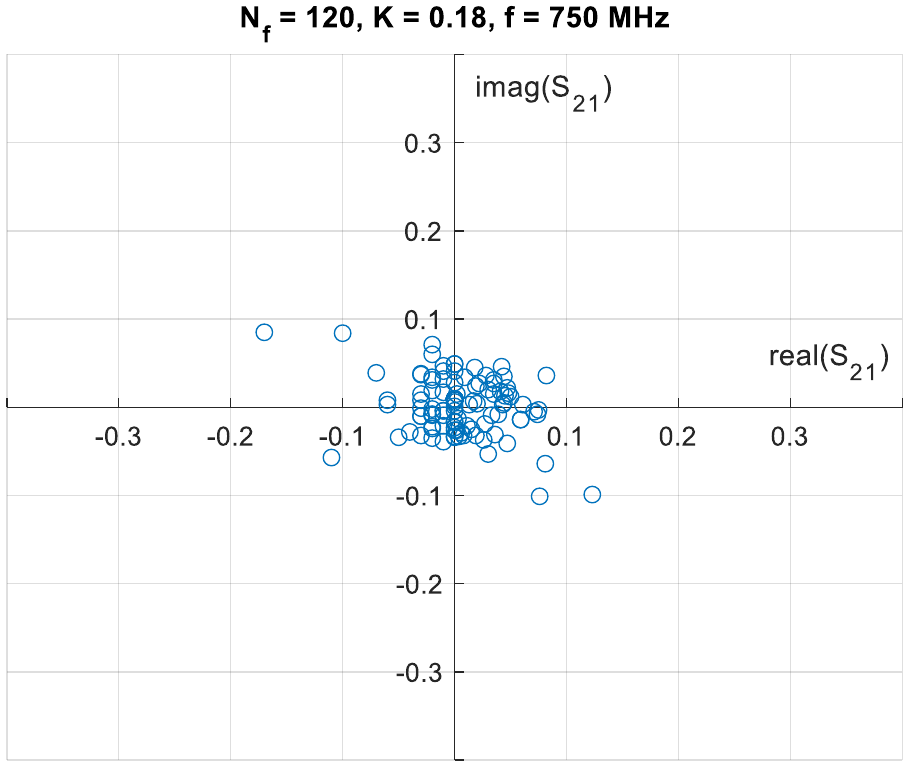
Figure 4. Scatter plot of S 21 relative at a 120 electromagnetic field realization, simulated at 750 MHz. The corresponding value of the Rician K-factor is 0.18.